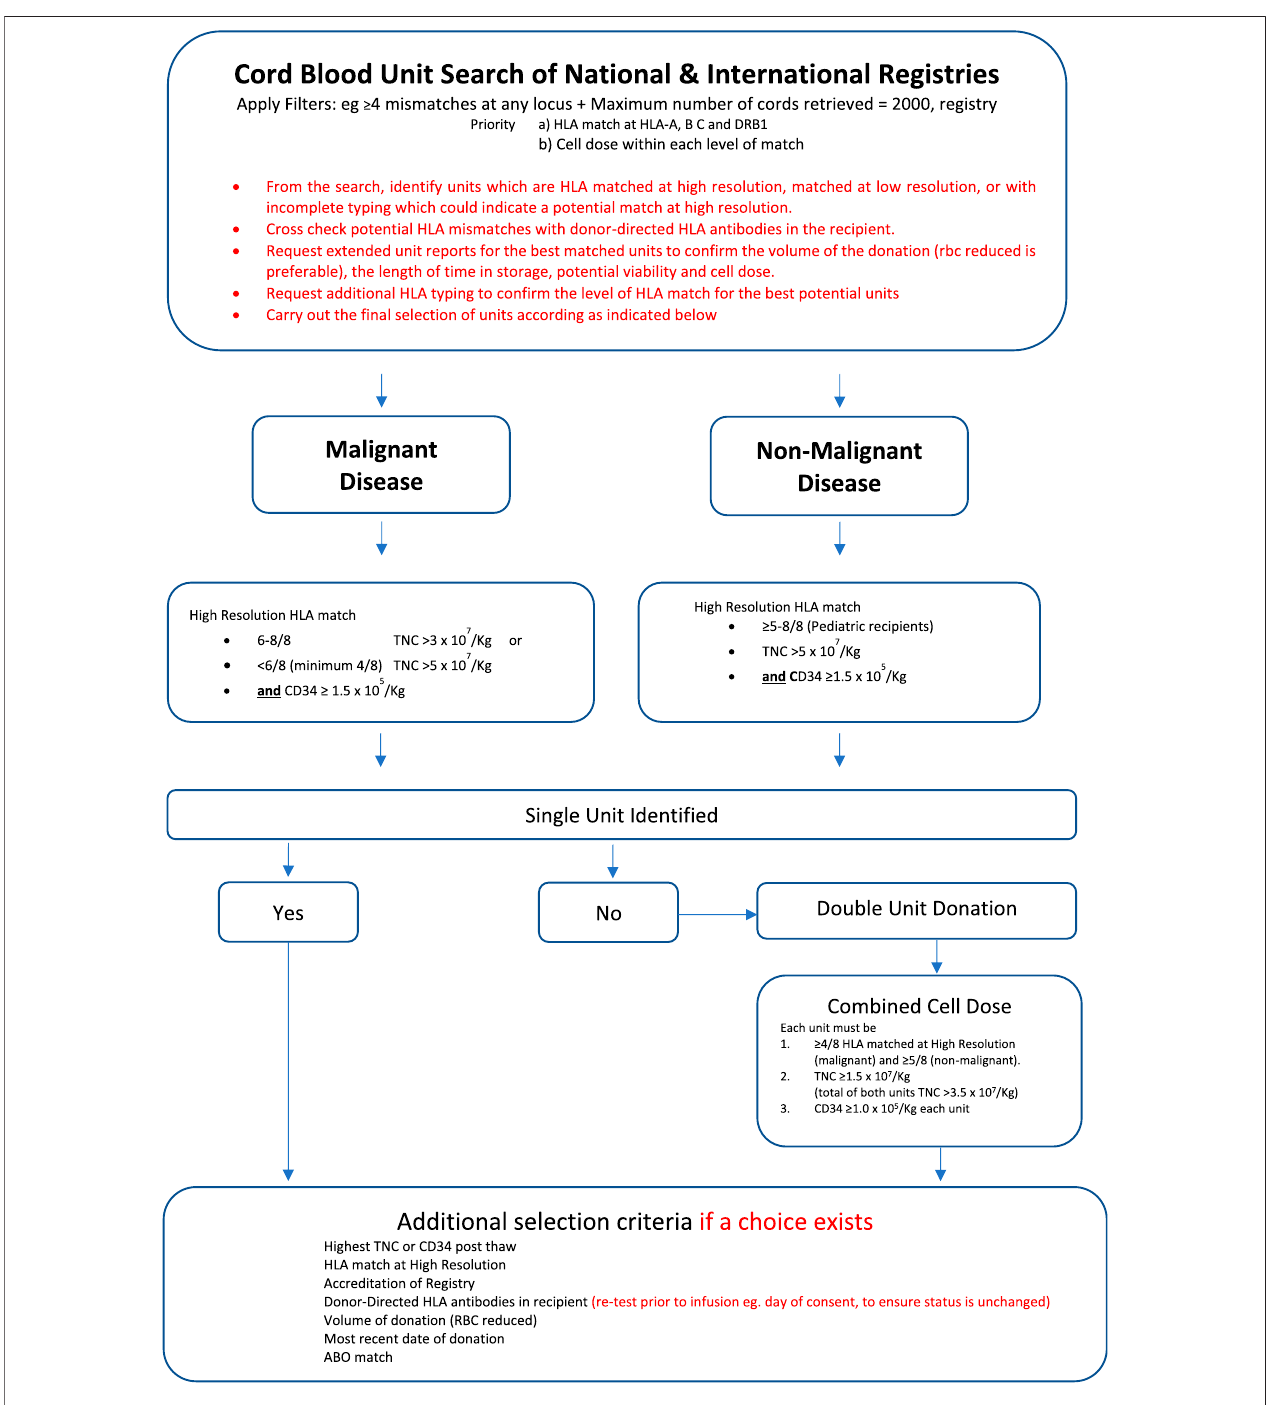
FIGURE 1 | Algorithm for the selection of matched CBU donors for malignant and non-malignant (Little et al., 2021).